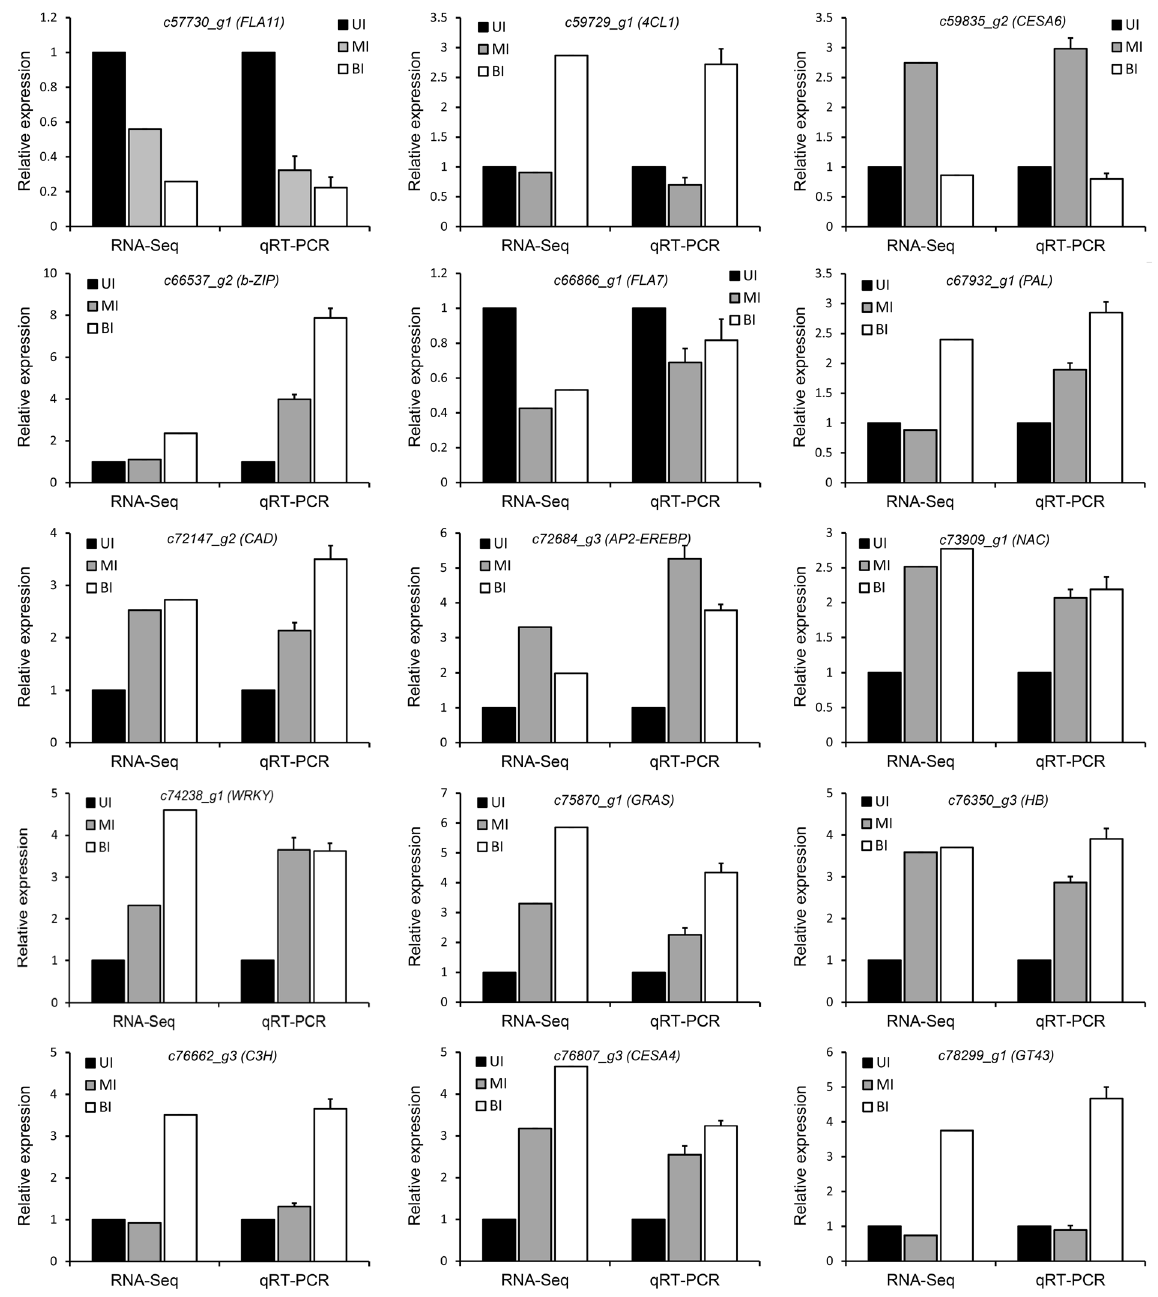
Figure 9. Validation of gene expression by quantitative real time RT-PCR. The expression of the UI was set as 1.0, and the relative expression level was calculated. UI, upper internode, MI, middle internode, BI, basal